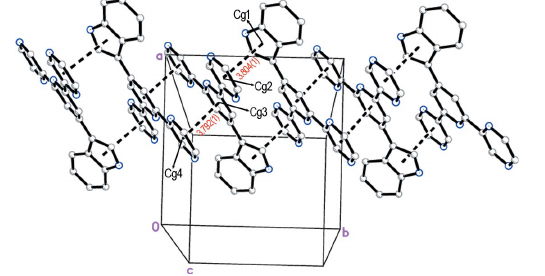
Figure 3 The aromatic (cid:2) – (cid:2) interactions (dashed lines) in the title compound.